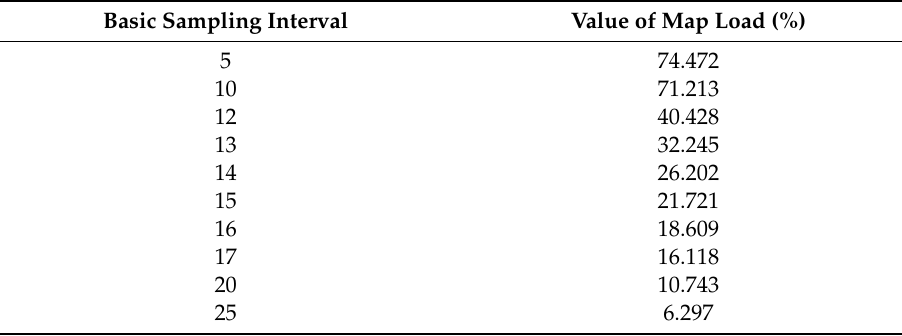
Table 4. Corresponding table of basic sampling interval and map load.